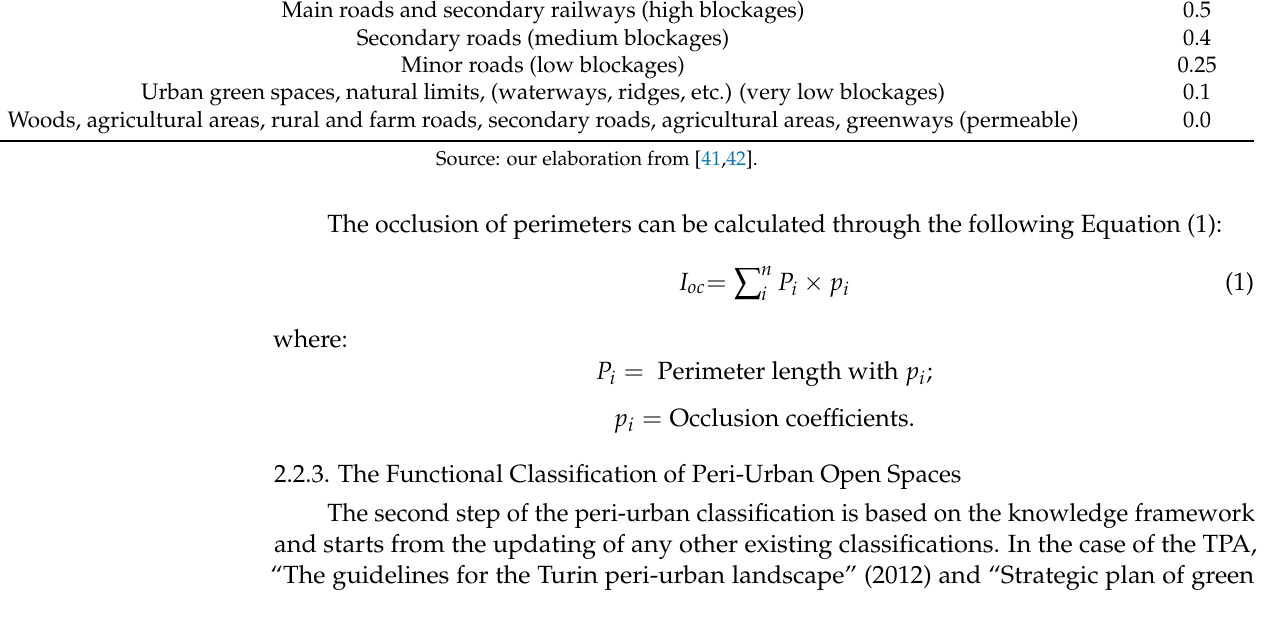
Figure 3. Flowchart.